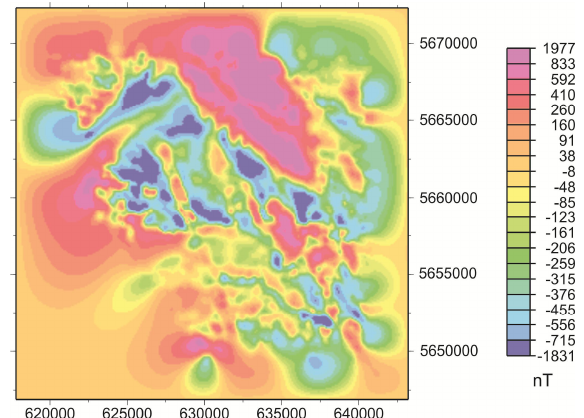
Fig. 6. Magnetic data after extrapolation to a rectangular area. Measured data remain unchanged. Edges are zero. Coordinates in metres are UTM zone 21.